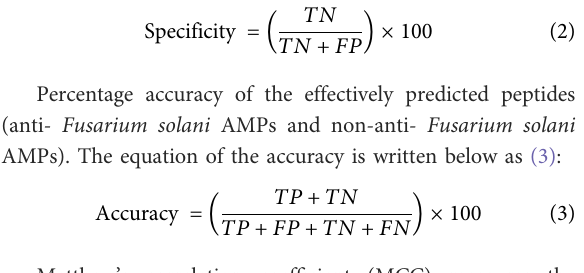
FIGURE 1 Detailed representative structural representation for Antimicrobial peptides (AMPs) model